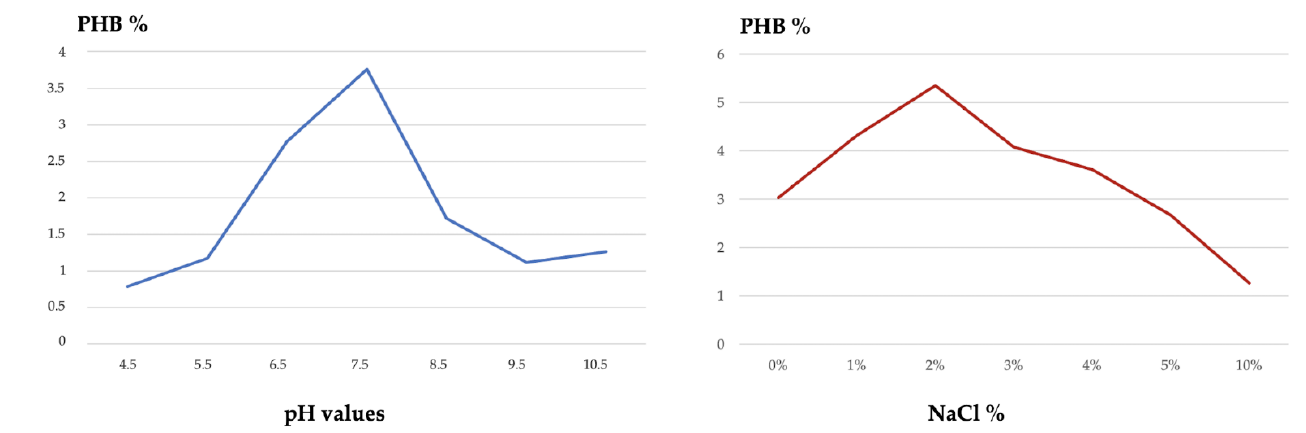
Figure 6. Effect of different pH values and NaCl concentrations on the putative PHB final yield.